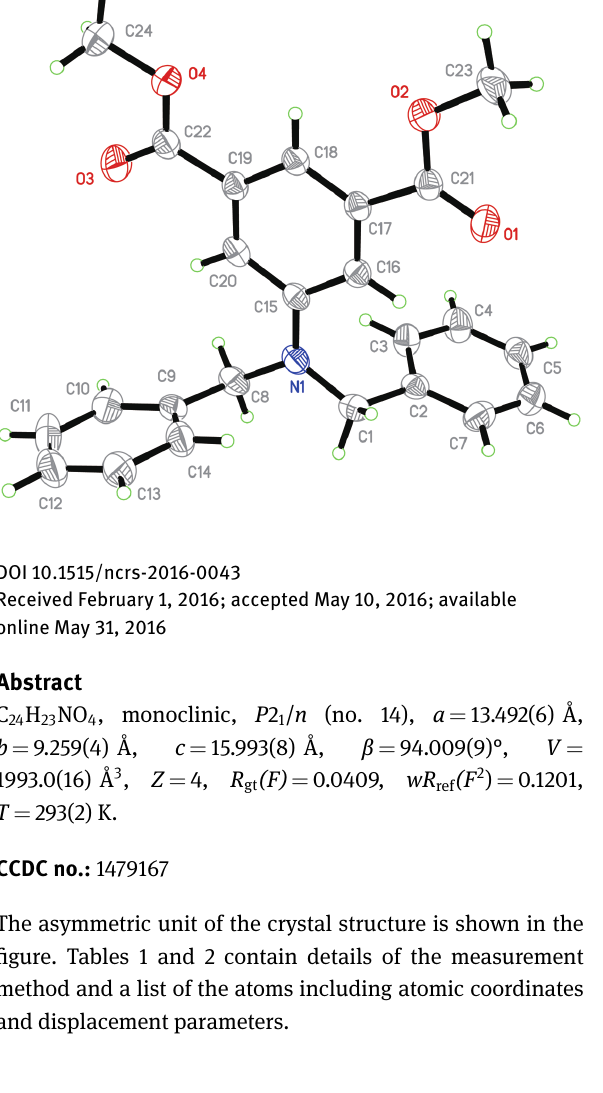
Table 1: Data collection and handling.